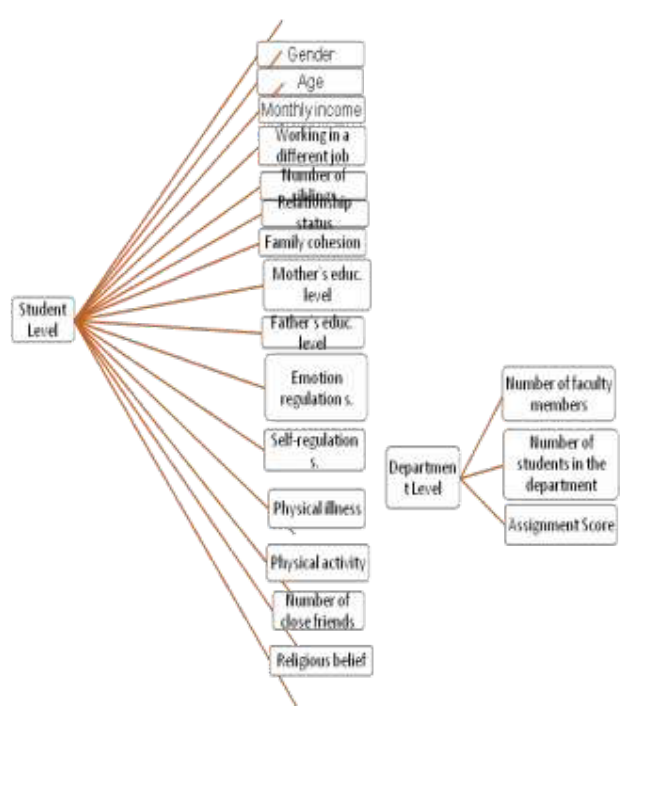
Figure 1. Variables used in the